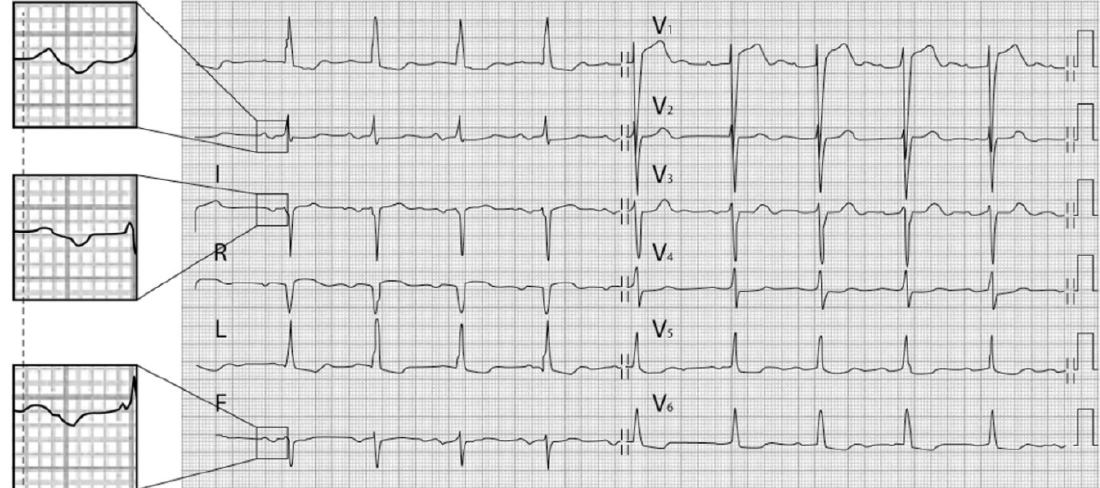
Figure 3. Examples of the 3 types of atrial activity: ( A ) normal P-wave (P-wave duration <120 ms), ( B ) partial interatrial block (P-wave duration ≥120 ms), ( C ) advanced interatrial